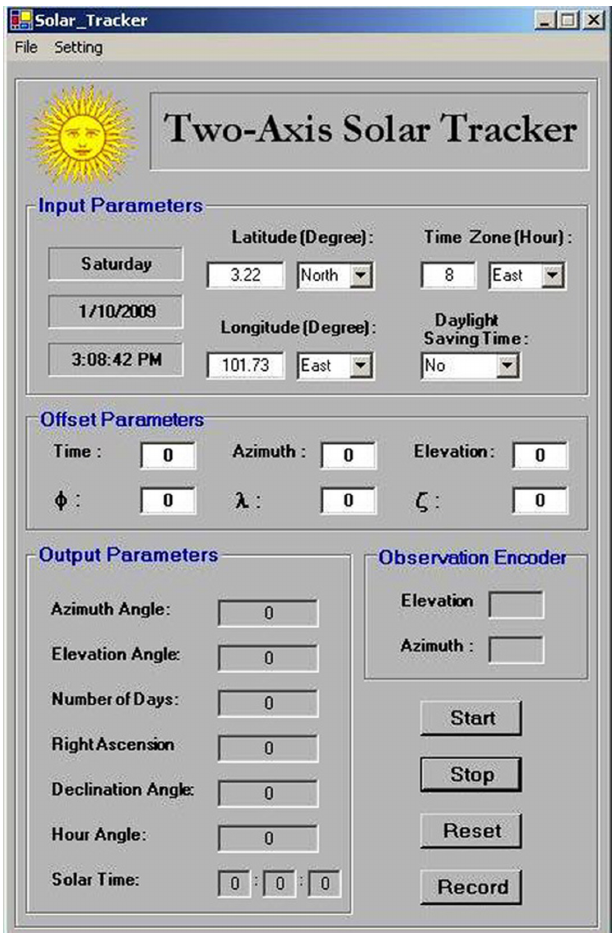
Figure 3. A Windows-based control program that has been integrated with the on-axis general